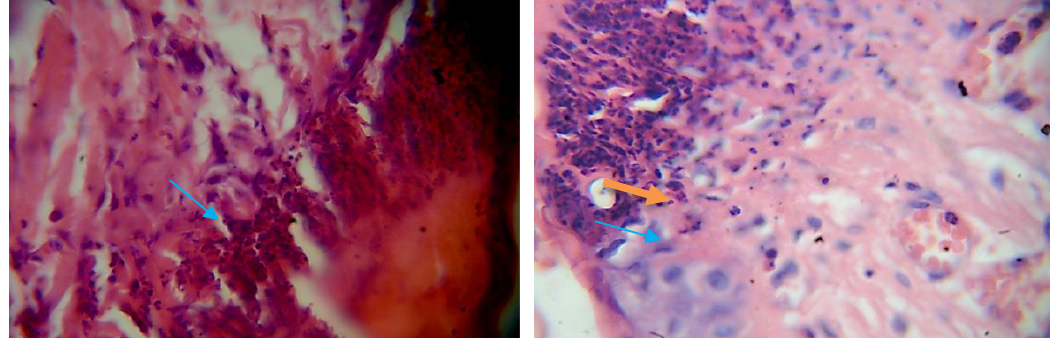
Figure, 5: shows fiber connective tissue proliferation infiltrated by inflammatory cell extended to necrotic area in the dermis and epidermis , 7 days post operation in control group (H&E 40X).